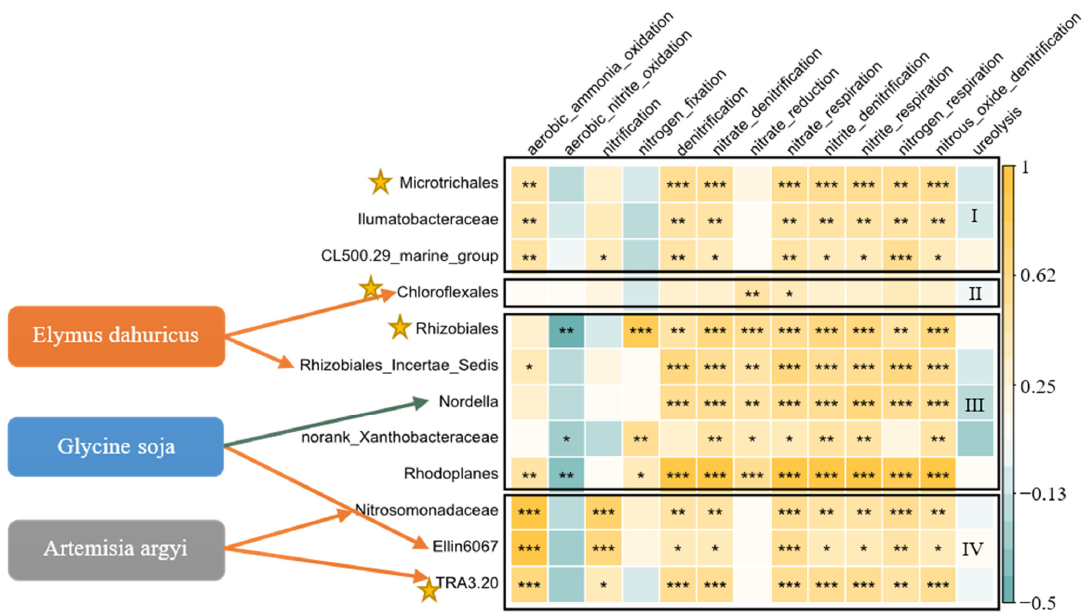
Figure 7. Pearson correlations between bacterial biomarkers and the functional groups of nitrogen metabolic and mutual plants at the Yanmagou site and Guangrong site. The key biomarkers are marked by the yellow star. * p < 0.05; ** p < 0.01; *** p < 0.001